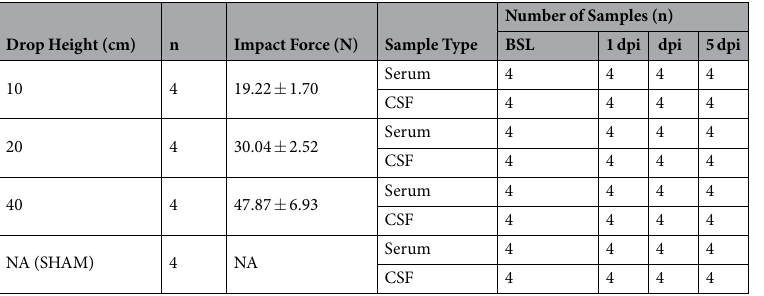
Table 1. Study parameters. The number of animals in each injury group is shown with their respective injury heights and recorded impact forces in Newtons (N), along with the number of samples collected for each sample